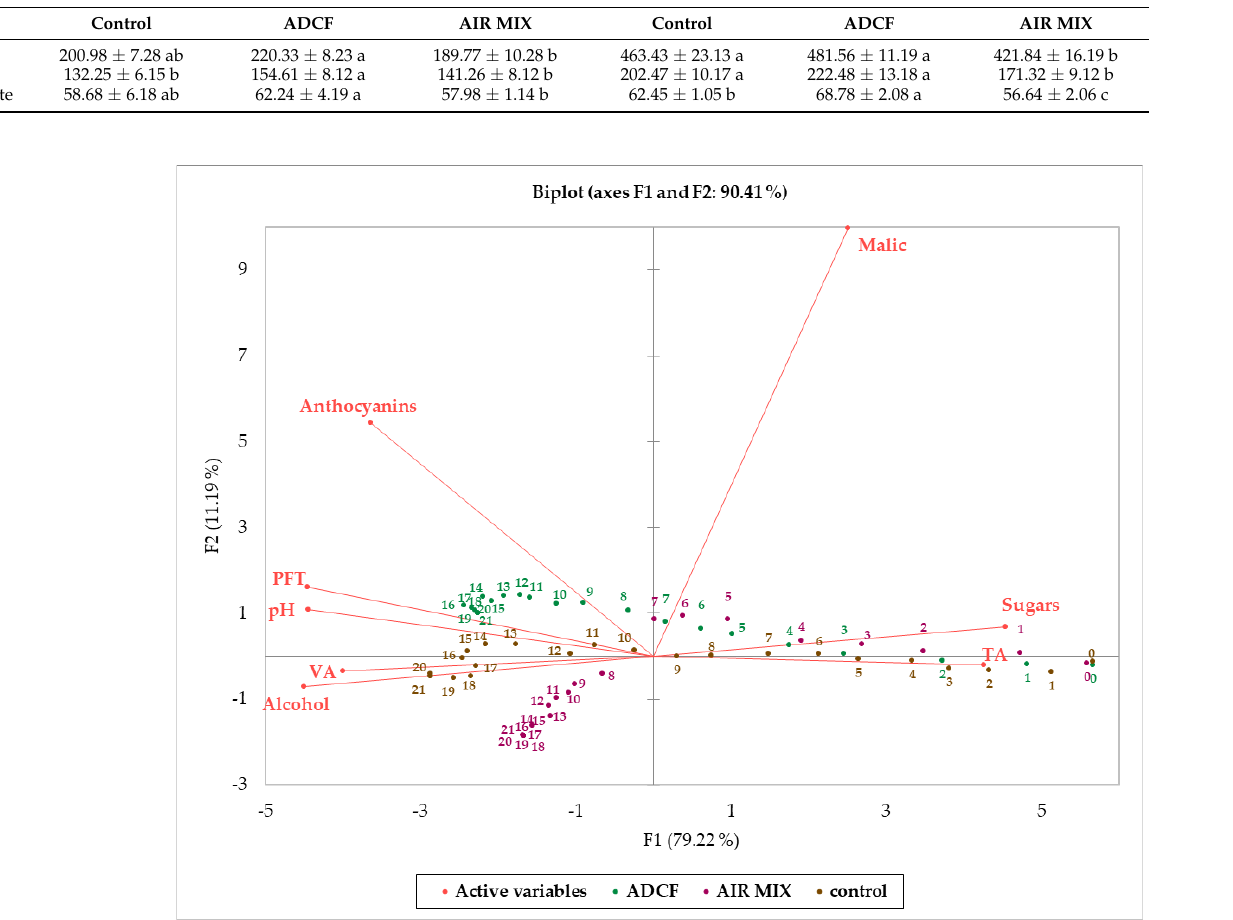
immediately after wine mixing in the tank. Different letters (each year) in a row indicate statistically